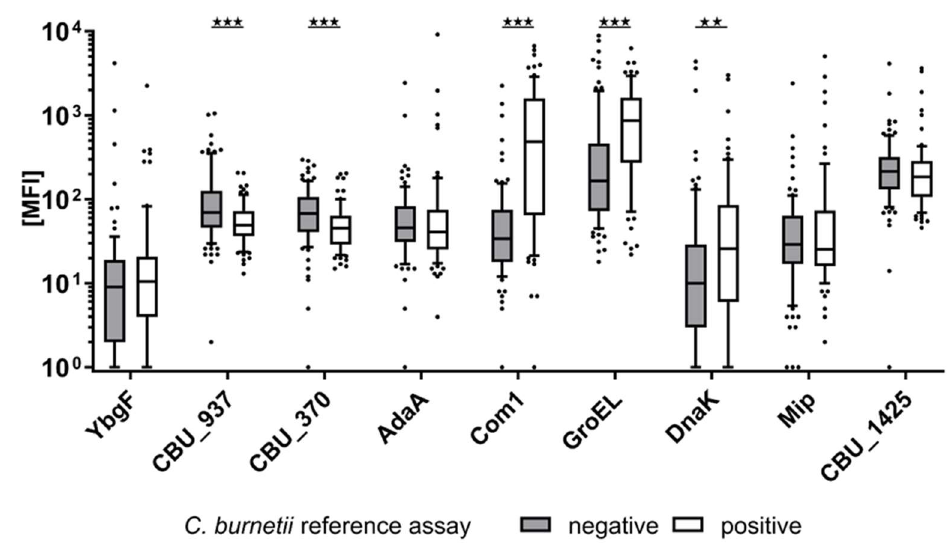
Figure 1. Antibody levels in the reference panel of 76 C. burnetii seropositive and 91 seronegative reference samples. CBU_937, CBU_370, Com1, and GroEL show a significantly different distribution ( p < 0.05) between the two reference groups. Stars above boxplots indicate the level of significance, p < 0.01 (**); p < 0.01 (***). Table 2. Quantitative seroresponses to nine selected C. burnetii antigens measured with multiplex serology in a serum dilution of 1:100. Reference samples were grouped according to a positive (pos.) or negative (neg.) C. burnetii reference assay test result. Groups were compared using Mann–Whit- ney U test. A p -value below 0.05 was considered statistically significant.